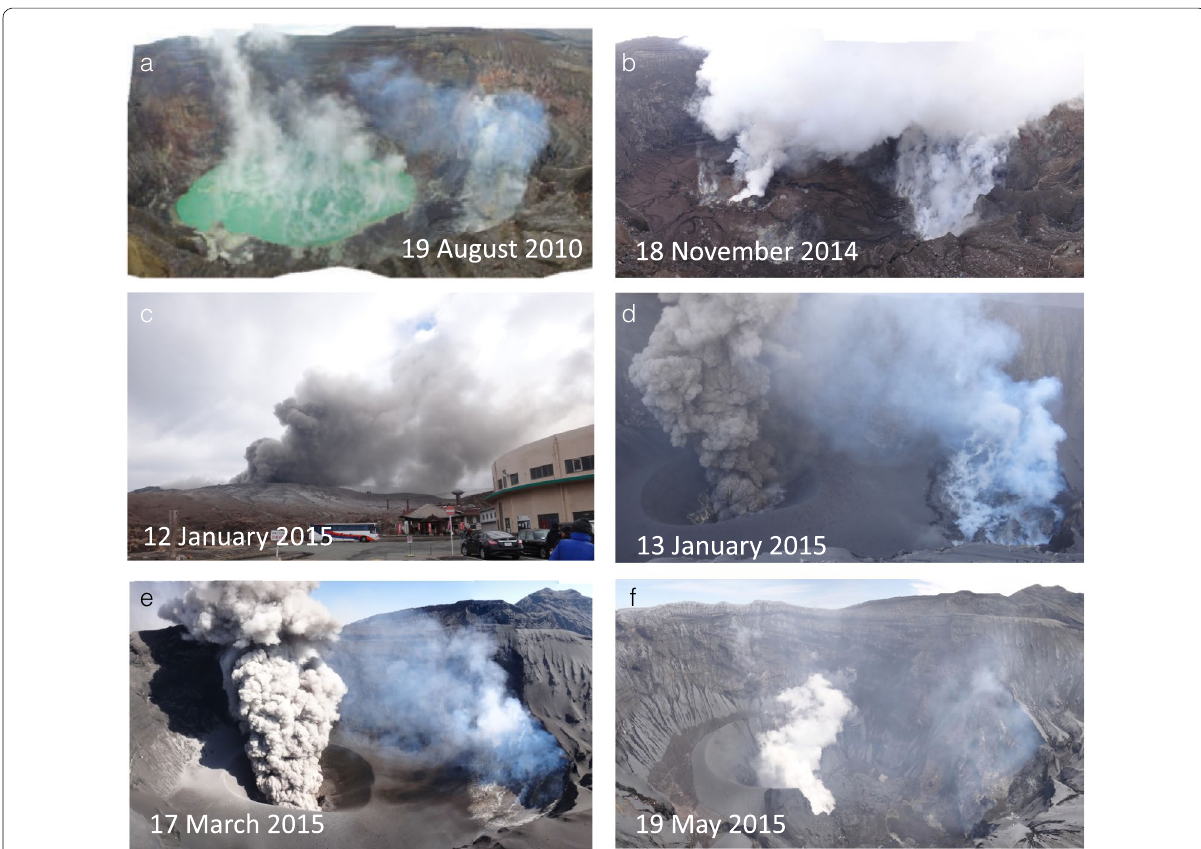
Fig. 2 Photographs of the degassing and eruptive activities at the Nakadake crater, Aso volcano. All photographs, except c , were taken from the location 4 in Fig. 1, and show the two separate degassing sources of the main vent (or the crater lake) on the left and the fumaroles on the southern rim on the right. a The crater lake and the fumarolic area during the quiet period on August 19, 2010. b Gas emission occurs at the main vent after disappearance of the crater lake and the fumaroles on November 18, 2014. c Intensive ash eruption on January 12, 2015. d The intermediate ash eruption on January 13, 2015. e The weak ash eruption on March 17, 2015. f Gas emission from the main vent on May 19,